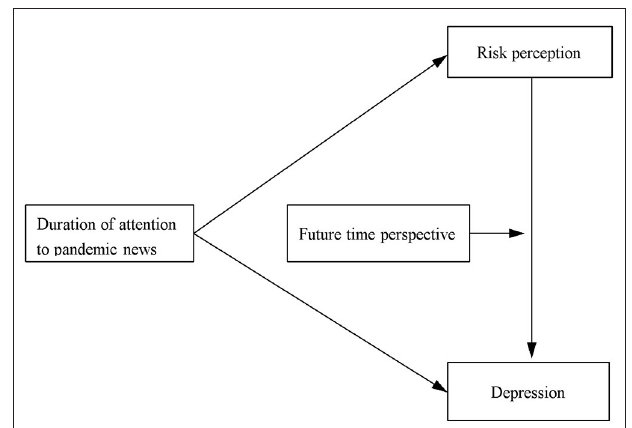
FIGURE 1 | The proposed moderated mediation